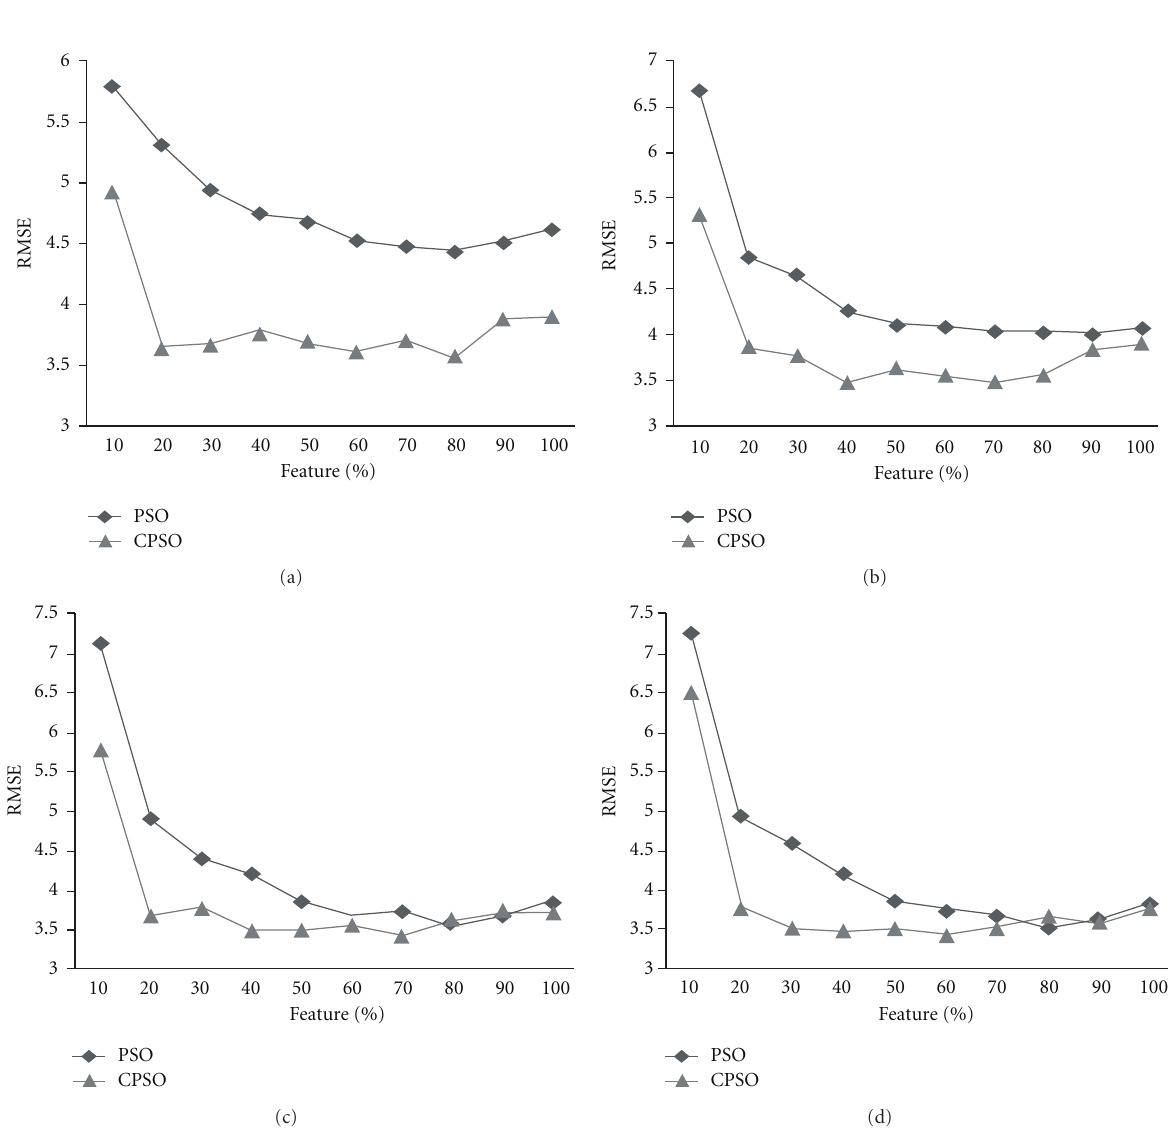
Figure 11: Values of RMSE versus the percentage of features selected when running PSO and CPSO—the use of the housing dataset: (a) 20% of selected data, (b) 30% of selected data, (c) 50% of selected data, and (d) 70% of selected